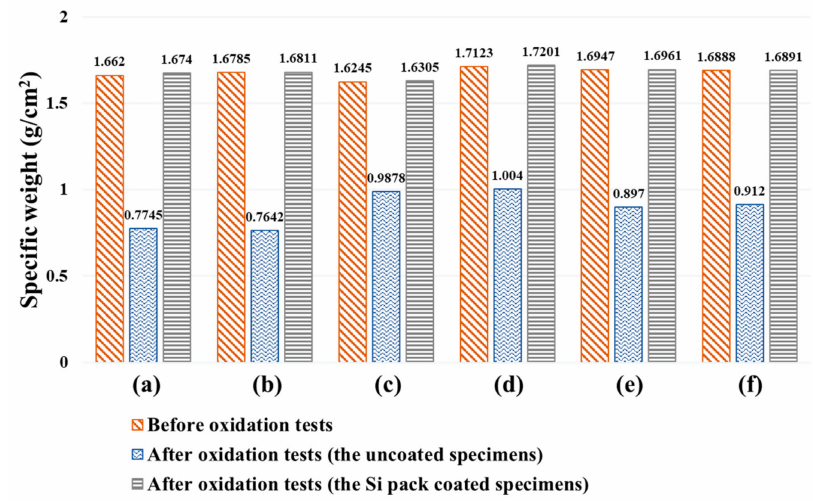
Figure 9. Specific weight of uncoated and coated specimens with respected to alloy compositions of ( a ) Alloy 1 (Nb), ( b ) Alloy 2 (Nb 73.6 Mo 26.4 ), ( c ) Alloy 3 (Nb 51.2 Mo 48.8 ), ( d ) Alloy 4 (Nb 35.1 Mo 64.9 ),